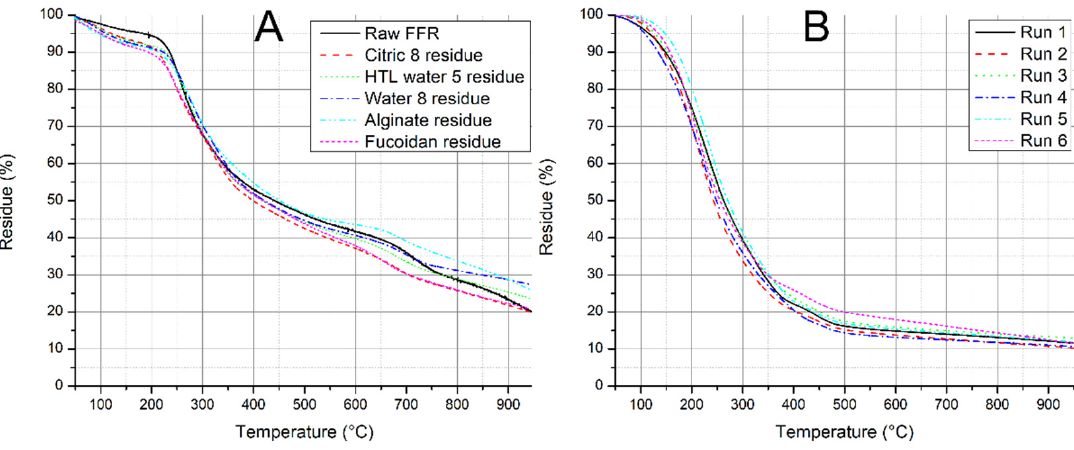
Figure 2. TGA curves representing raw biomass, leaching residues, and extraction residues ( A ), and the six produced biocrudes ( B ).